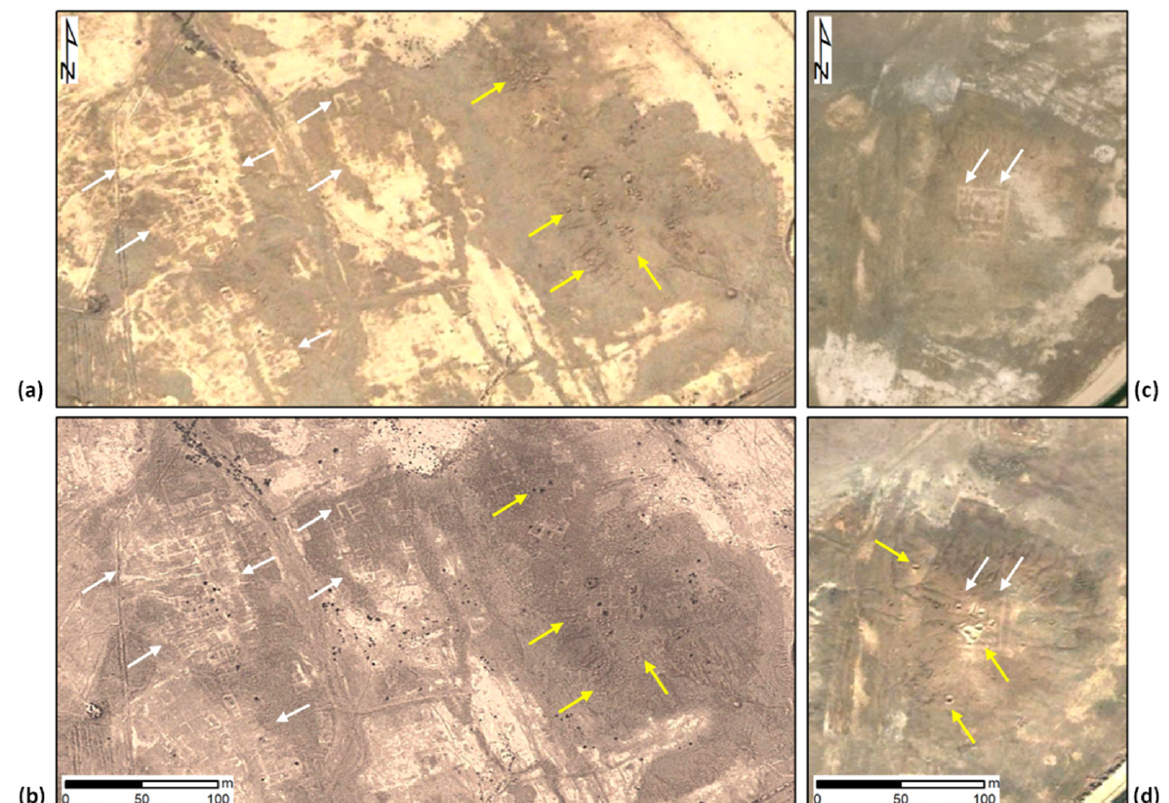
Figure 12. Selection of tells (precise location undisclosed for security concerns) with evidence of looting (yellow arrows) in areas where crop- and soil-marks highlight the presence of buried walls (white arrows), as observed from Google Earth imagery collected on ( a ) 1 January 2005 versus ( b ) 13 March 2010, respectively, and ( c ) ESRI basemap imagery and ( d ) Google Earth imagery, the latter collected on 21 November 2004. Google Earth image © 2021 Maxar Technologies.